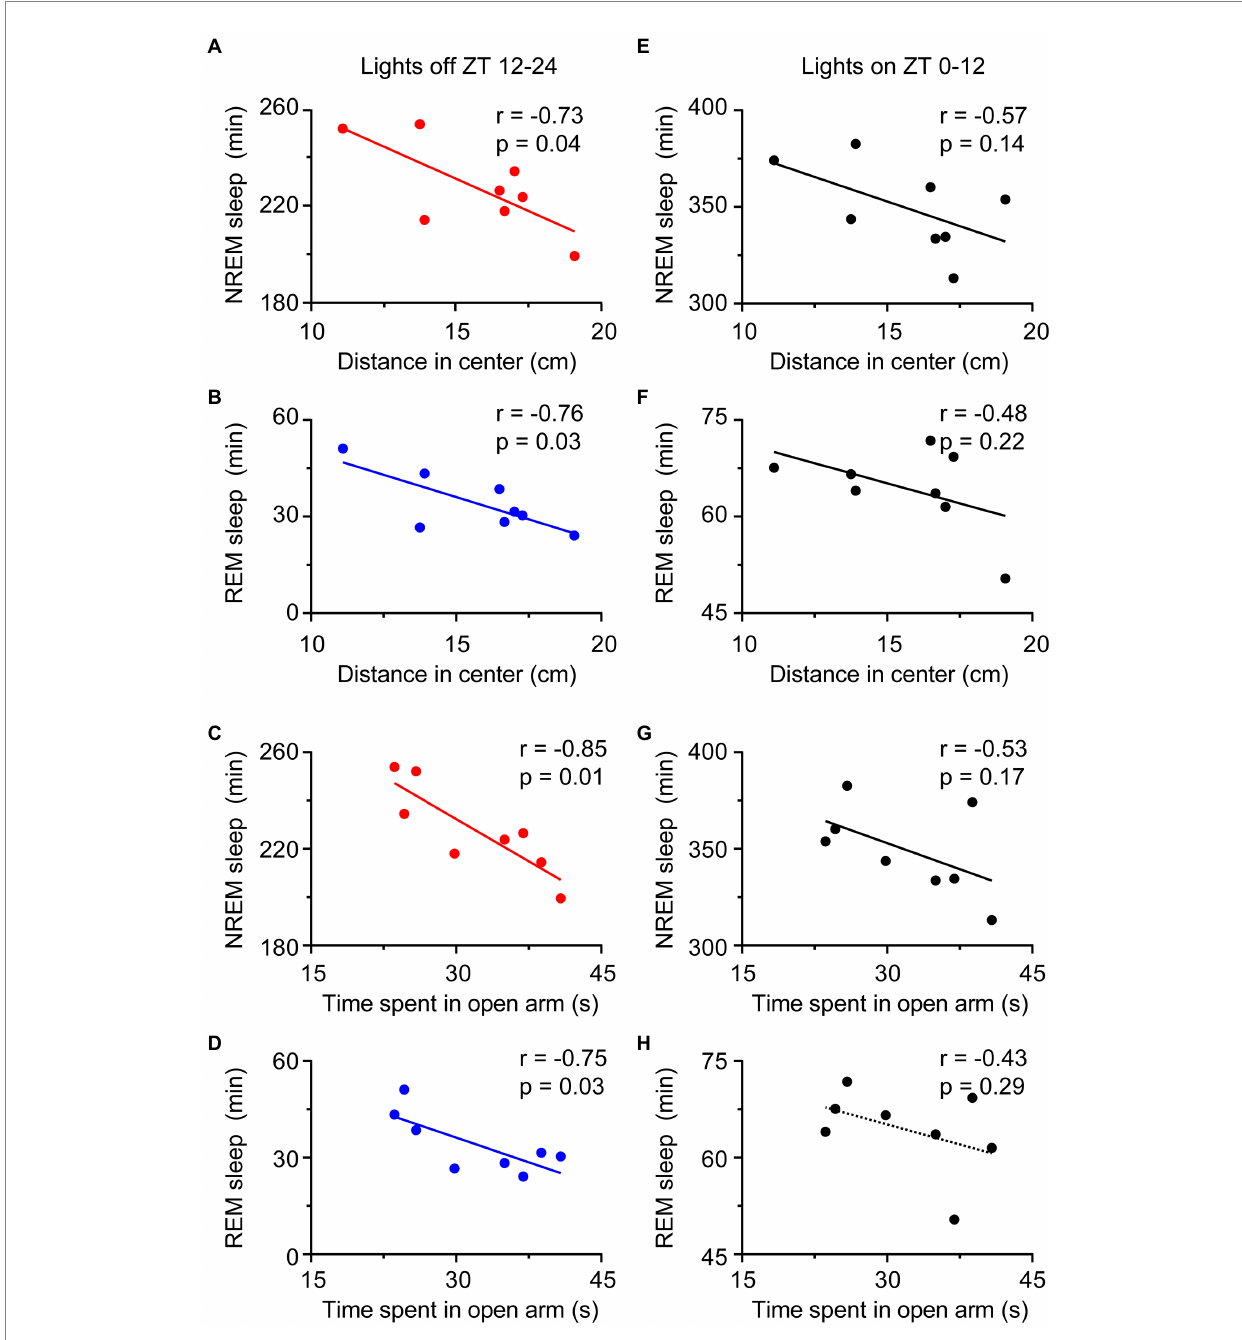
FIGURE 8 Relationship of sleep amount and anxiety-like behaviors during the PRS condition. The amount of NREM and REM sleep during the night period correlated with anxiety-like behaviors (A–D) , but the amount of NREM and REM sleep during the day period was not correlated with anxiety-like behaviors (E–H) . n = 8. ZT, Zeitgeber